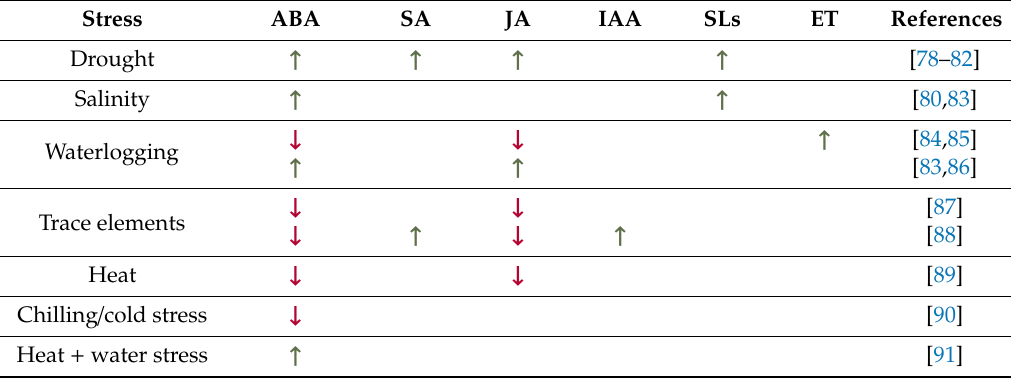
Table 1. Changes in hormonal content in roots of plants under di ff erent abiotic stress